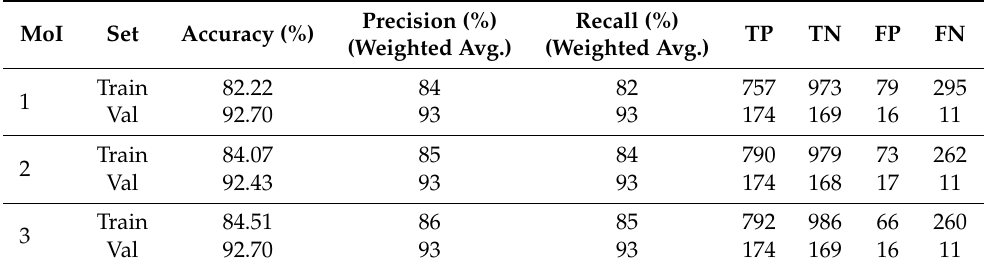
Table 1. Performance metrics for PICNN 1 with respect to the training and validation data sets when the model is trained via each